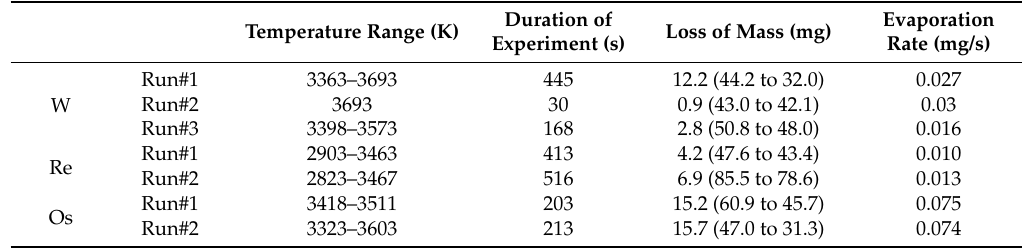
Table 5. Estimation of evaporation rate using loss of mass during surface tension/ viscosity measurements. Temperature Range